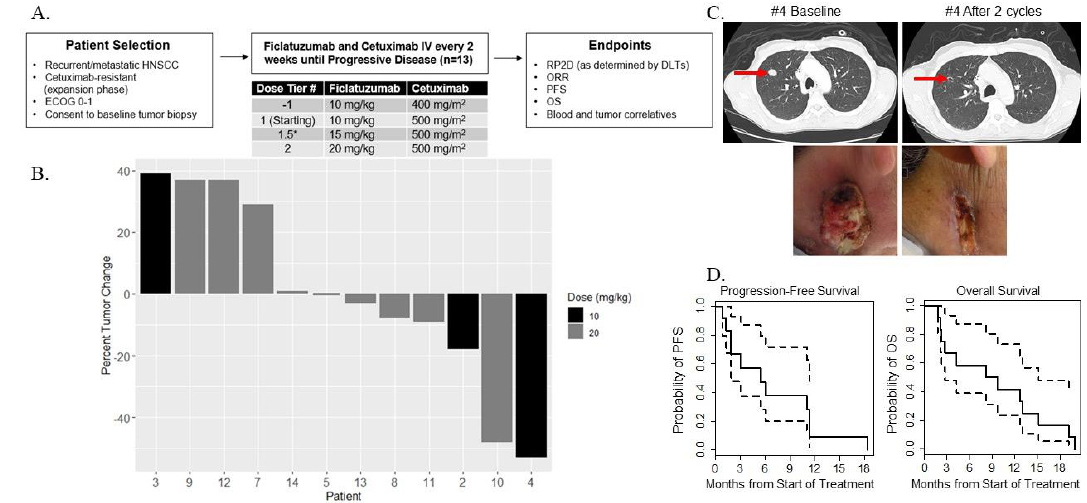
Figure 1. ( A ) Dose tier escalation rules and treatment schema. ( B ) Waterfall plot showing percent change in tumor burden by patient and by ficlatuzumab dose. Twelve patients were treated—three at 10 mg / kg (black bars) and nine at 20 mg / kg (gray bars) ficlatuzumab. ( C ) Representative lung CT images (top) and clinical photographs (bottom) of patient #4 at baseline and after two treatment cycles. ( D ) Kaplan–Meir curves (solid lines) with 95% CIs (dotted lines) showing PFS (left panel) and OS (right panel) in months. Time to progression and death were measured from first day of on-protocol treatment.